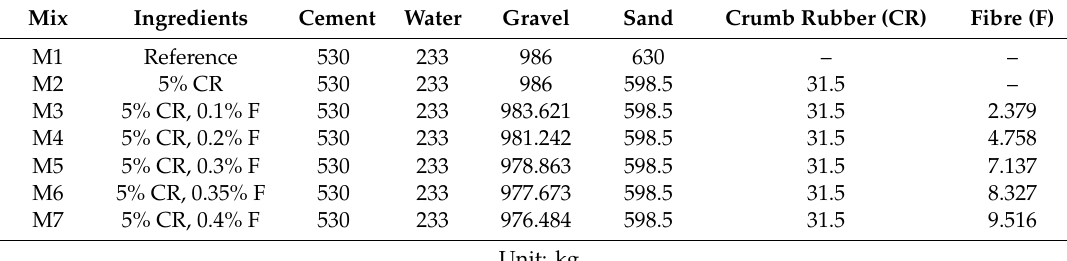
Table 2. Concrete design.